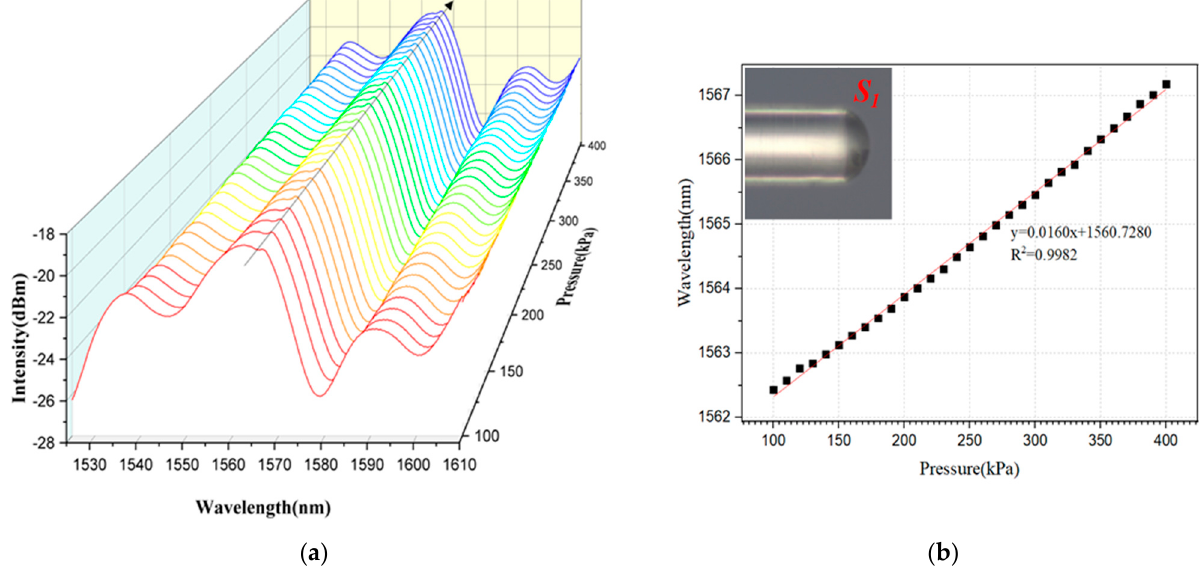
Figure 10. ( a ) The gas pressure (ranging from 100 to 400 kPa, in strides of 10 kPa) response interference spectrum of S 1 (AB/PDMS); and ( b ) pressure sensitivity of S 1 .